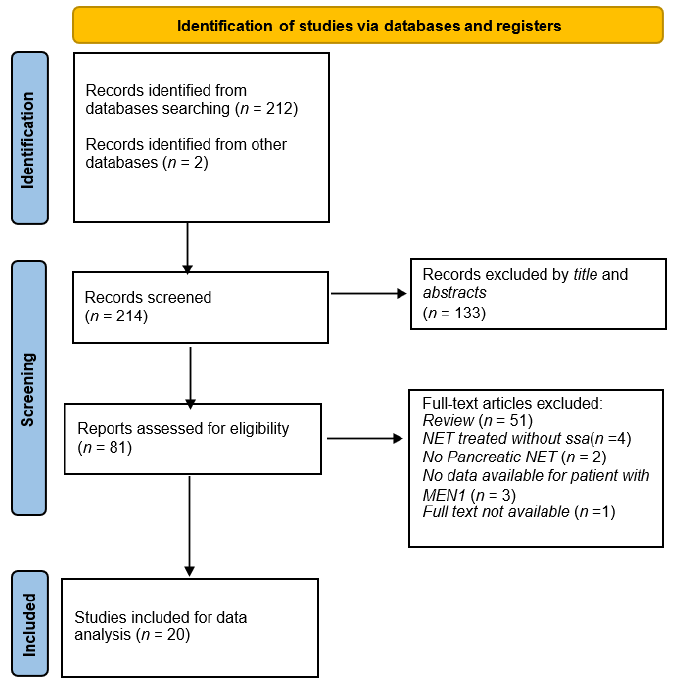
Figure 1. PRISMA flow diagram.